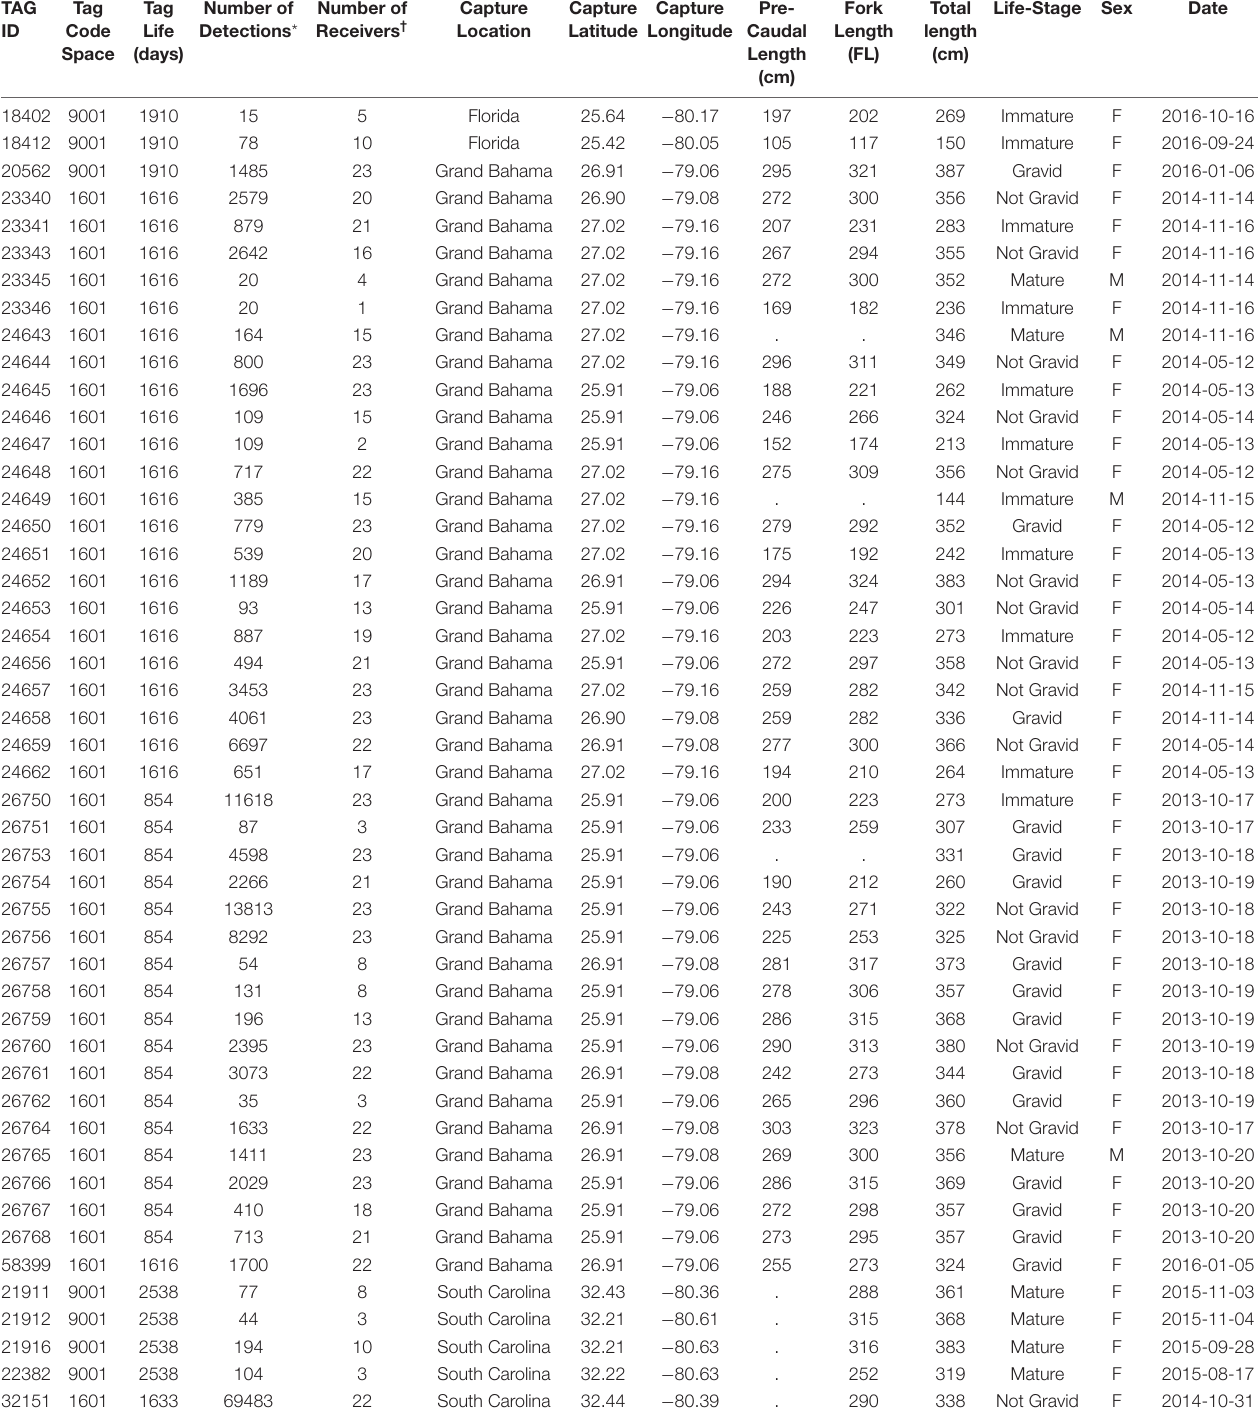
TABLE 1 | Summary of the 48 tiger sharks tagged with acoustic transmitters that occurred during our three-year study at Tiger Beach, The Bahamas. TAG Tag Tag ID Code Space